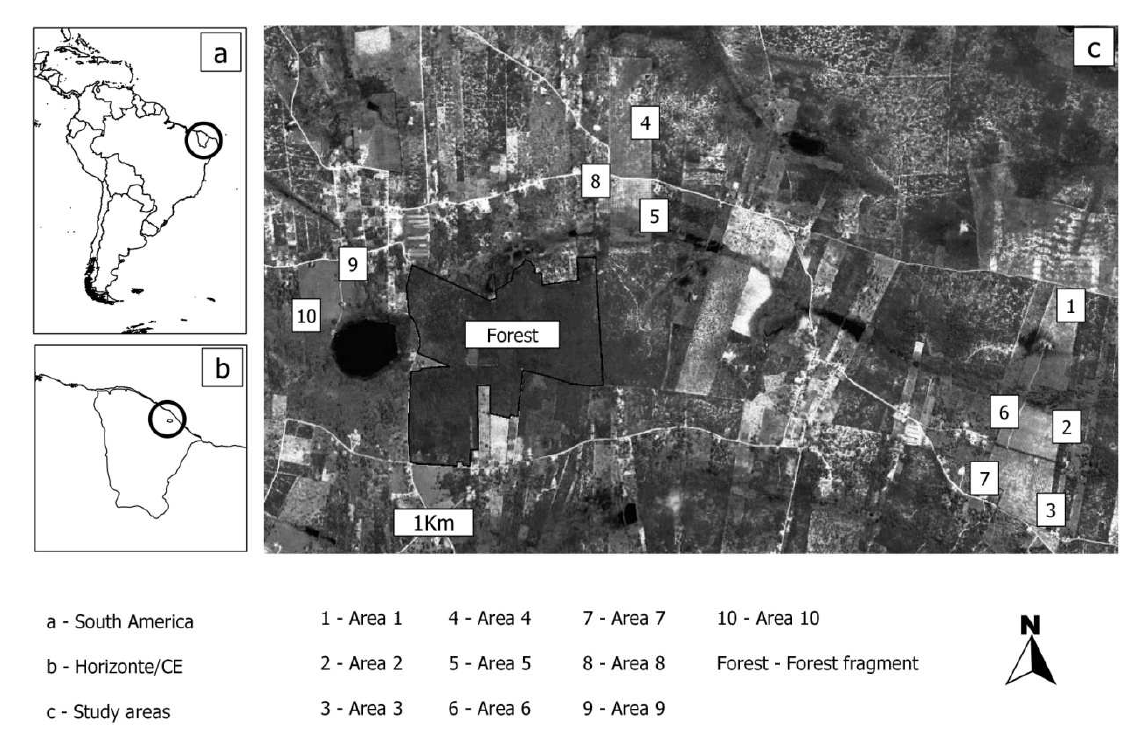
F IGURE 1. Location of the study areas: a – South America map showing Brazil and highlighting the state of Ceará; b – the county of Horizonte (circled) in the state of Ceará; c - satellite image showing the 105 ha large forest fragment and the five nearby (<1 km) and five distant (>2.5 km) cashew plantation